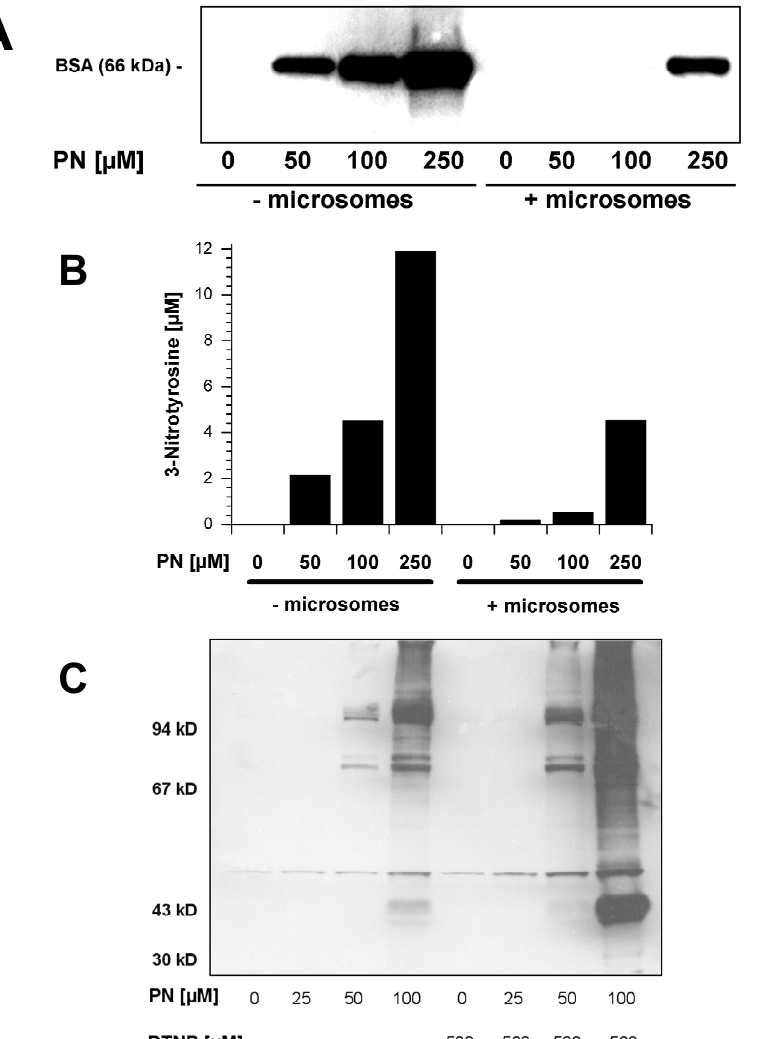
Figure 3. Effects of bovine aortic microsomes on the nitration of bovine serum albumin (BSA) and of Ellman’s reagent on the nitration of PGIS and other proteins by peroxynitrite. ( A ) Detection of 3-nitrotyrosine in BSA by Western blot analysis using a monoclonal anti-3-nitrotyrosine antibody. BSA (5 μ M) was incubated with authentic peroxynitrite (PN, 0–250 μ M) in the presence or absence of bovine aortic microsomes (1 mg/mL total protein); ( B ) HPLC analysis of free 3-nitrotyrosine content in pronase digests from samples used for Western blot; ( C ) Detection of 3-nitrotyrosine positive proteins in bovine aortic microsomes by Western blot analysis using a monoclonal anti-3-nitrotyrosine antibody. Bovine aortic microsomes (1 mg/mL total protein), which were either treated or not with the sulfhydryl oxidizing Ellman’s reagent (DTNB) were mixed with authentic peroxynitrite (PN, 0–100 μ M). Data are representative of two independent